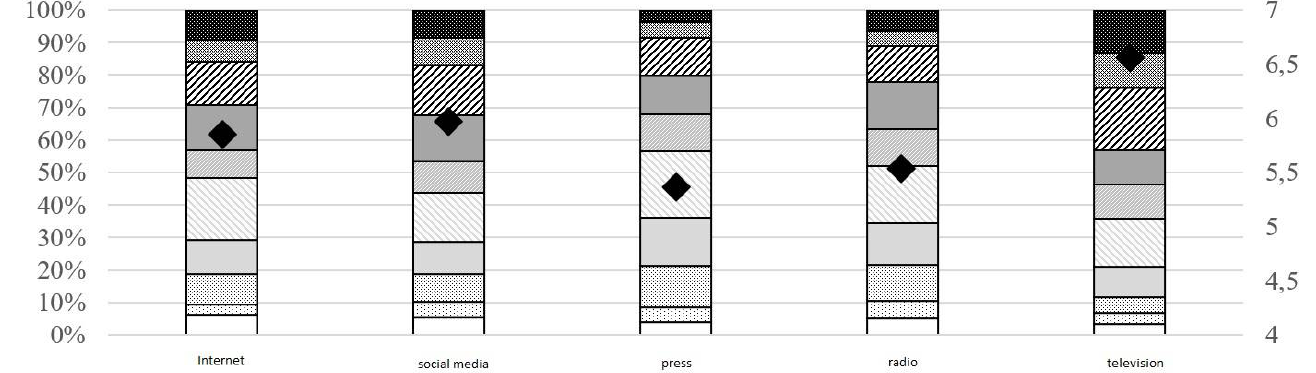
Figure 7. Assessment of the role of various means supporting image building. Source: authors’ own elaboration.